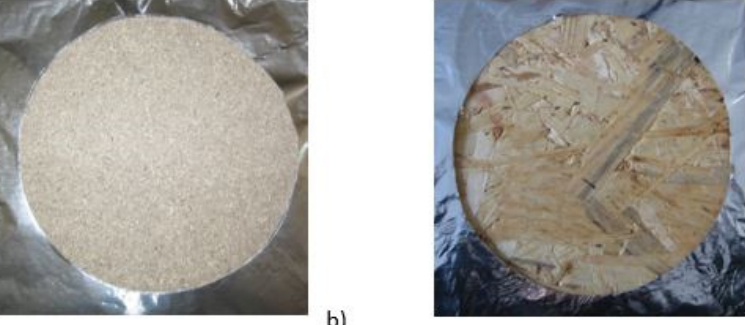
Figure 1. Example of experimental samples prepared in accordance with ISO 5657 [65]: ( a ) particleboard (PB); ( b ) OSB.